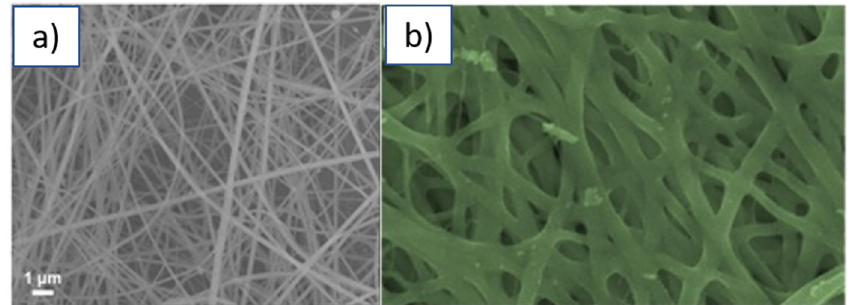
Figure 13. ( a ) nanofibres IrO 2 /PVP synthesised through electrospinning (adapted from ref. [111]; ( b ) Hollow nanofibres of IrO 2 after thermal annealing at 300 °C (Reprinted/adapted with permission from Ref. [78]).